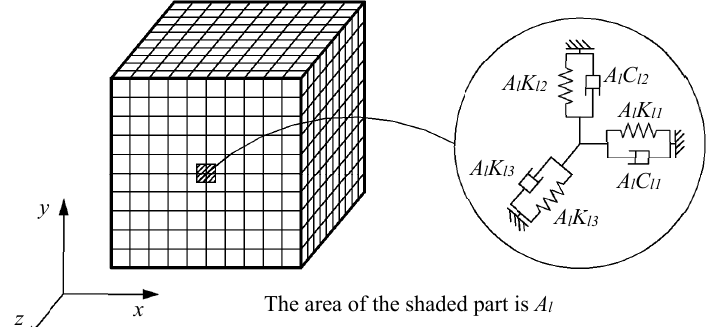
The area of the shaded part is A l Figure 3. The 3D VSAB Figure 3. The 3D VSAB condition.